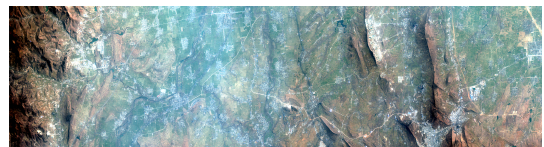
Figure 3. The multispectral image used in this experiment.